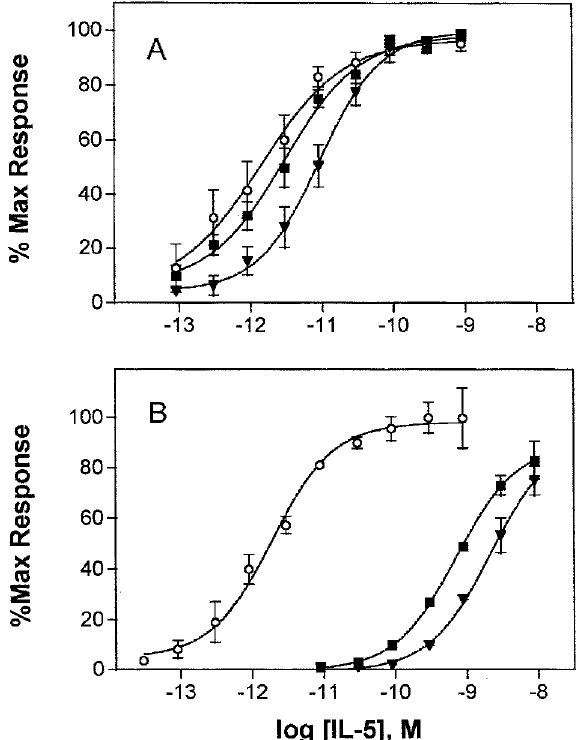
FIG. 5. Biological activity of IL-5 orthologs on human IL-5/TF- 1 cells and murine B13 cells. Both IL-5/TF-1 (A) and B13 (B) cells were incubated with increasing concentrations of gpIL- 5 ( . ), hIL-5 ( j ), or mIL-5 ( s ) for 72h and the proliferative response measured by incorporation of [ 3 H]thymidine as described in Methods. Data represent the mean±SEM from three experiments performed in